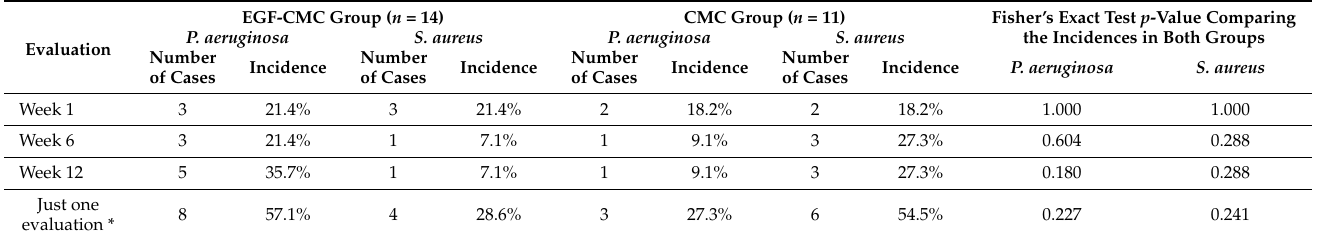
Table 2. Incidence of P. aeruginosa and S. aureus at three assessment points and overall incidence